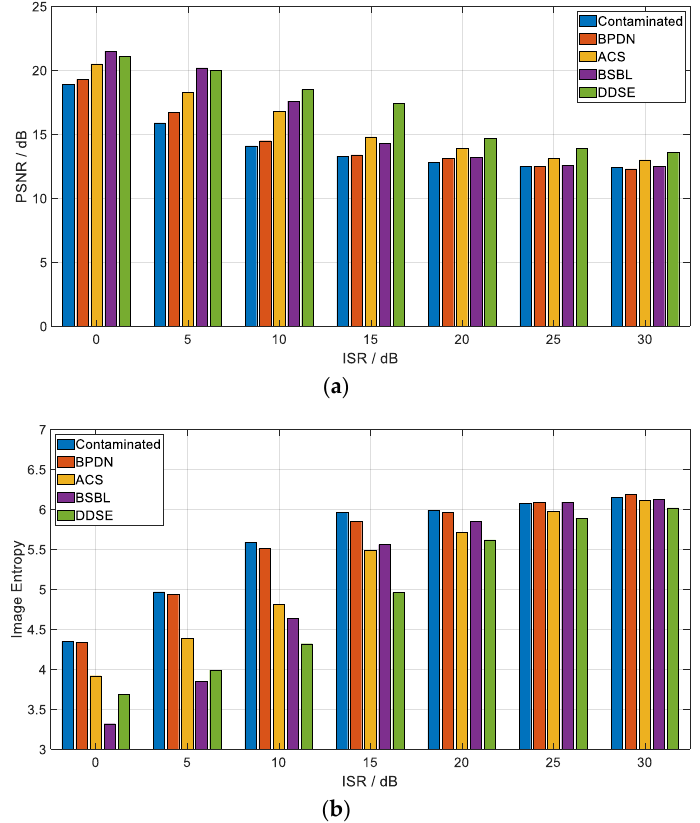
Figure 11. Range-azimuth imaging performances under different ISRs. ( a ) peak signal-to-noise ratio (PSNR); ( b ) image entropy.